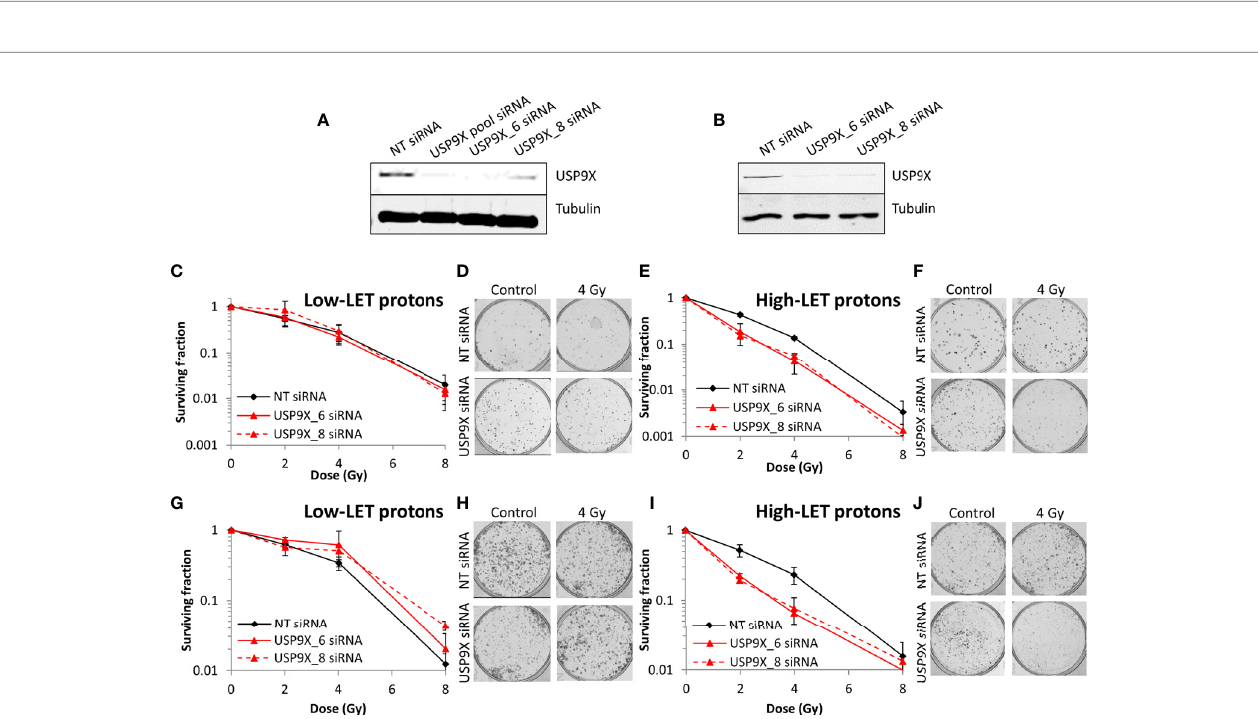
FIGURE 3 | Speci fi c targeting of USP9X leads to enhanced cellular radiosensitivity after relatively high-LET protons. (A – J) Cells were treated with individual USP9X siRNAs (USP9X_6 and USP9X_8) or a non-targeting (NT) control siRNA for 48 h. Whole cell extracts prepared from (A) HeLa or (B) UMSCC74A cells were analyzed by immunoblotting using USP9X or tubulin antibodies. HeLa cells were subsequently irradiated with increasing doses of (C, D) low-LET protons or (E, F) relatively high-LET protons. UMSCC74A cells were also treated with increasing doses of (G, H) low-LET protons or (I, J) relatively high-LET protons. Clonogenic survival of cells was analyzed from 3 independent experiments, and shown is the mean surviving fraction ± S.E. Shown are representative images of colonies from (D, F) HeLa cells or (H, J) UMSCC74A cells in non-irradiated and irradiated plates, the latter of which contained four times the number of cells seeded. A comparison of the surviving fractions at 2 Gy (SF2) by one-way ANOVA in HeLa cells reveals p < 0.05 (NT siRNA vs USP9X_6), p < 0.001 (NT siRNA vs USP9X_8) and in UMSCC74A cells, p < 0.05 (NT siRNA vs USP9X_6 and NT siRNA vs USP9X_8). At 4 Gy (SF4), one-way ANOVA values in HeLa cells are p < 0.01 (NT siRNA vs USP9X_6), p < 0.005 (NT siRNA vs USP9X_8) and in UMSCC74A cells, p < 0.05 (NT siRNA vs USP9X_6 and NT siRNA vs USP9X_8).